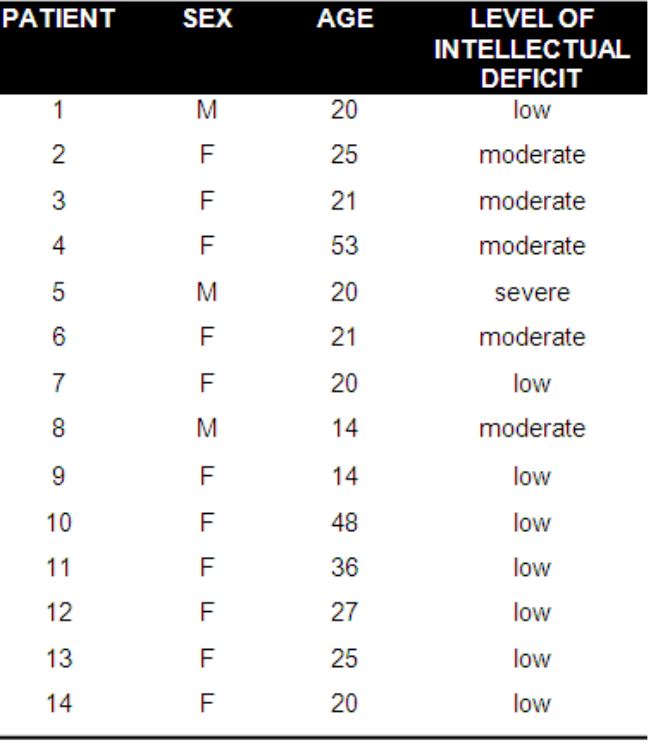
Table 1. Data from Down’s syndrome patients with periodontal disease